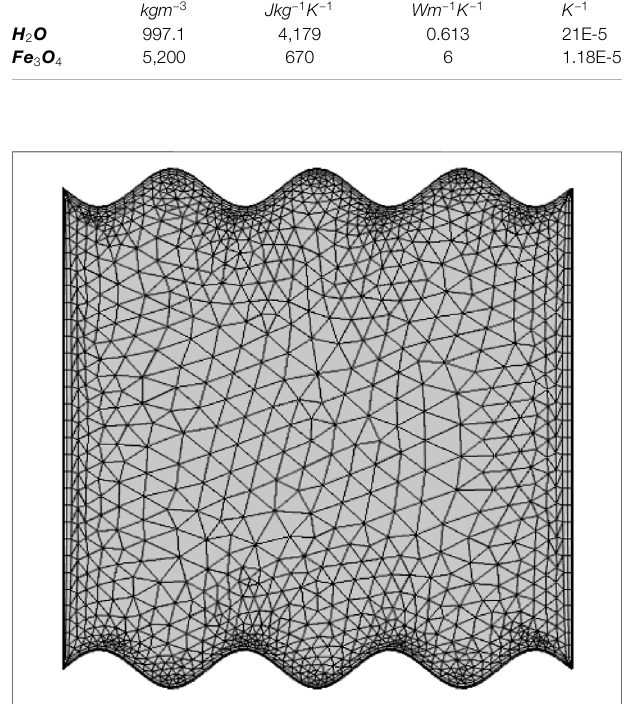
FIGURE 2 | Computational grid of the domain.